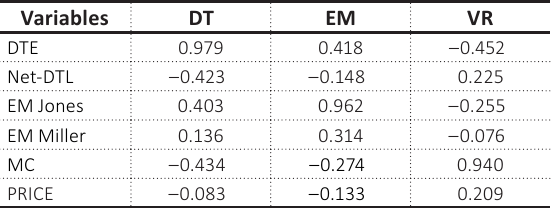
Table 5. Values of discriminant validity (cross-loading)